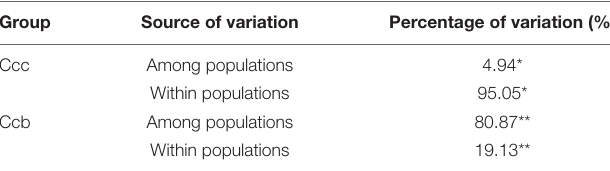
TABLE 2 | Analyses of molecular variance (AMOVA) of Ccc and